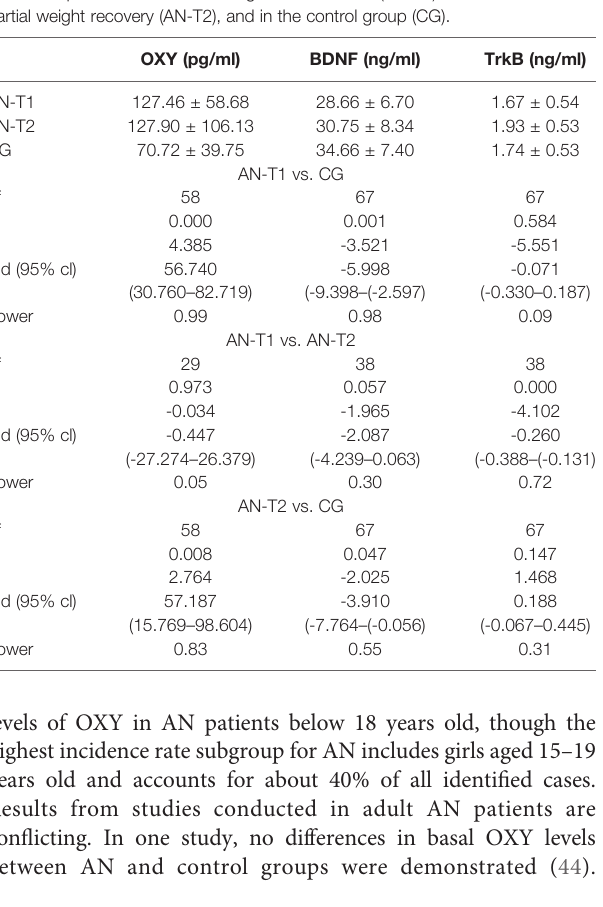
TABLE 2 | The serum oxytocin (OXY), brain-derived neurotrophic factor (BDNF), and tropomyosin-related kinase B receptor (TrkB) levels in the adolescent anorexic inpatients in the acute stage of the disease (AN-T1) as well as after partial weight recovery (AN-T2), and in the control group (CG). OXY